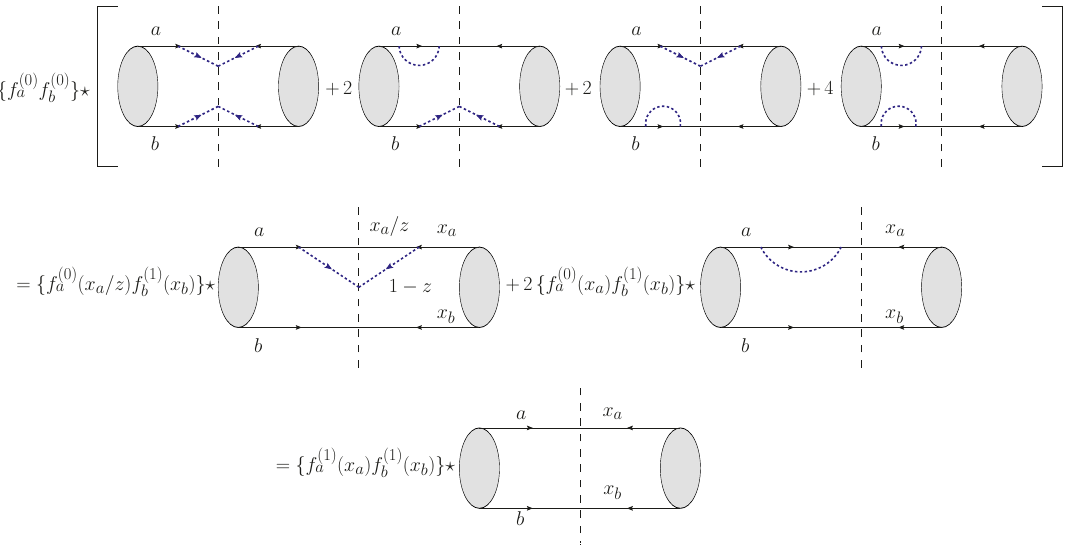
Figure 8. How DGLAP and fragmentation evolution can be constructed from the (cid:11) s expansion of our algorithm. The vertical dashed lines here correspond to a cut on all external legs (incoming and outgoing) and the grey blobs represent the hard process, i.e. the amplitude evolves from the right grey blob to the vertical dashed line and the conjugate amplitude evolves from the left grey blob to the vertical dashed line. Solid lines indicate hard partons and blue lines collinear